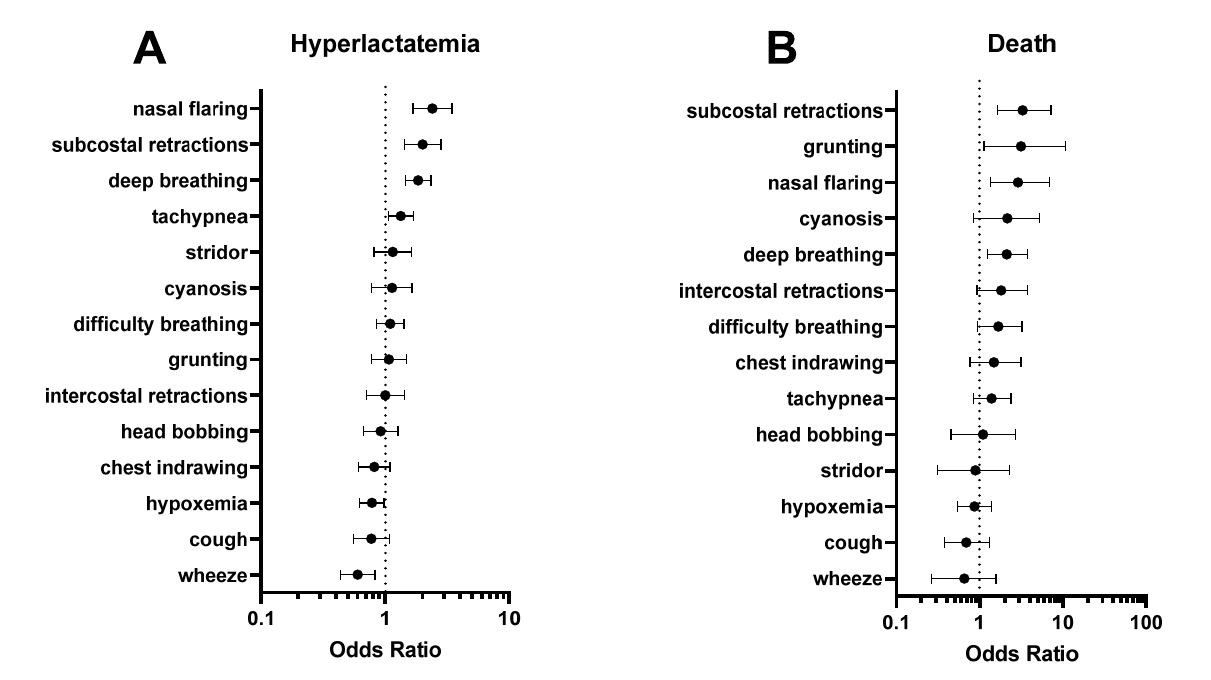
Figure 3. Association of clinical signs of respiratory distress with ( A ) hyperlactatemia and ( B ) death. Of note, deep (acidotic) respirations, nasal flaring, and subcostal retractions were associated with both hyperlactatemia and mortality. Closed circles represent the calculated odds ratio, and bars represent the 95% confidence interval.